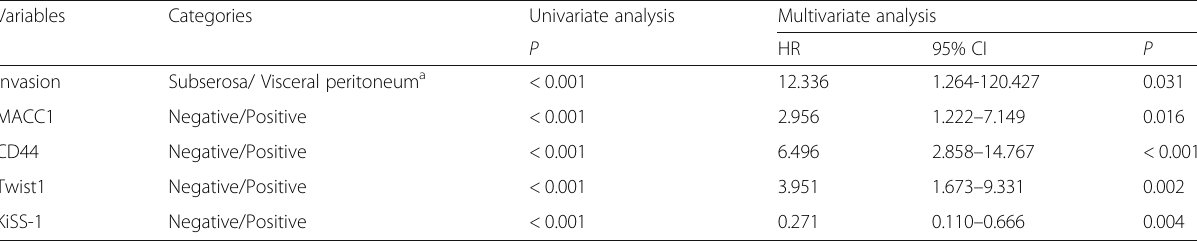
Table 4 Univariate analysis and multivariate analysis of factors affecting lymph node metastasis Variables Categories Univariate analysis Multivariate